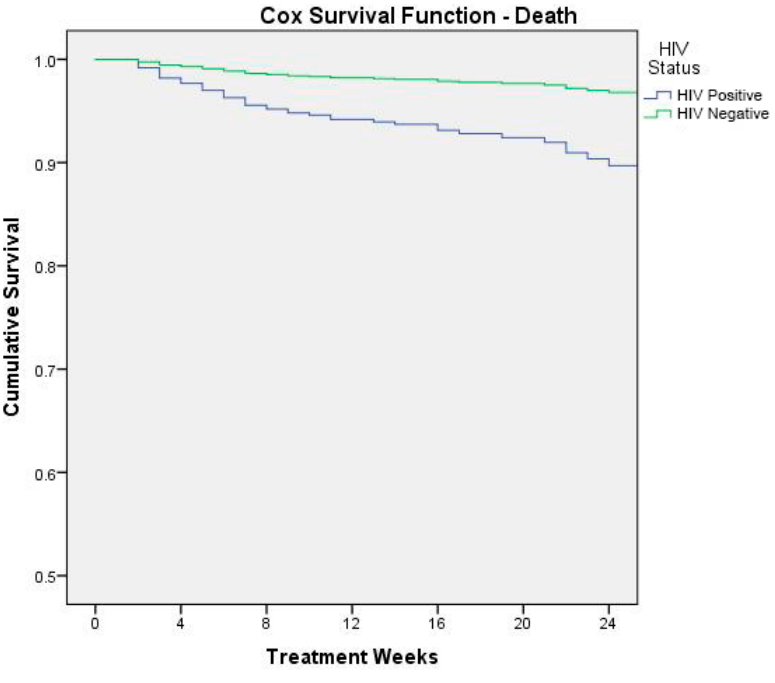
Figure 3. Cox survival analysis (outcome: death) by HIV status.